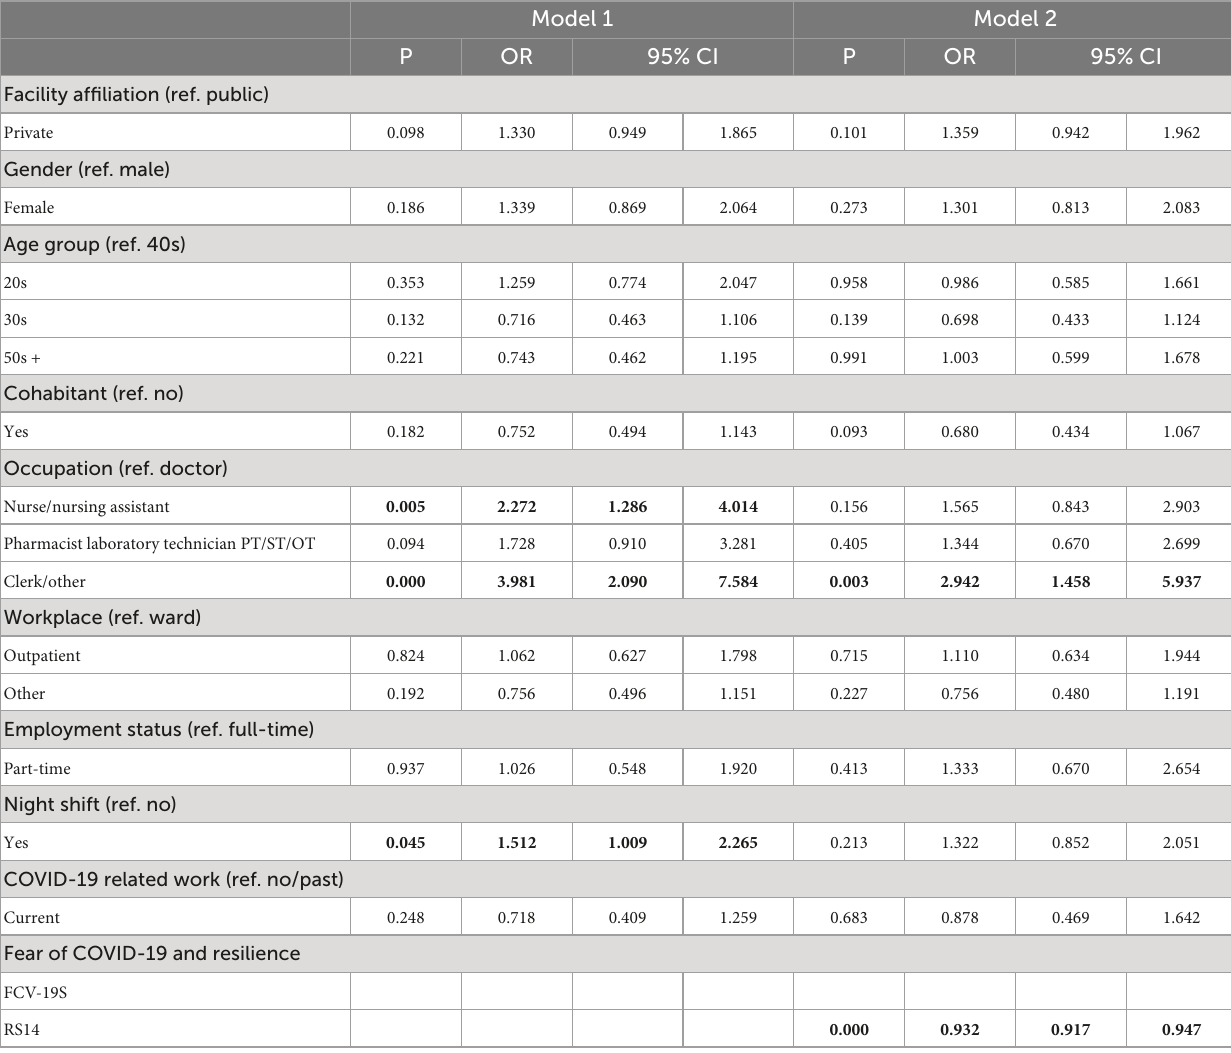
TABLE 2 Logistic regression analysis of psychological distress (Model 1 and Model